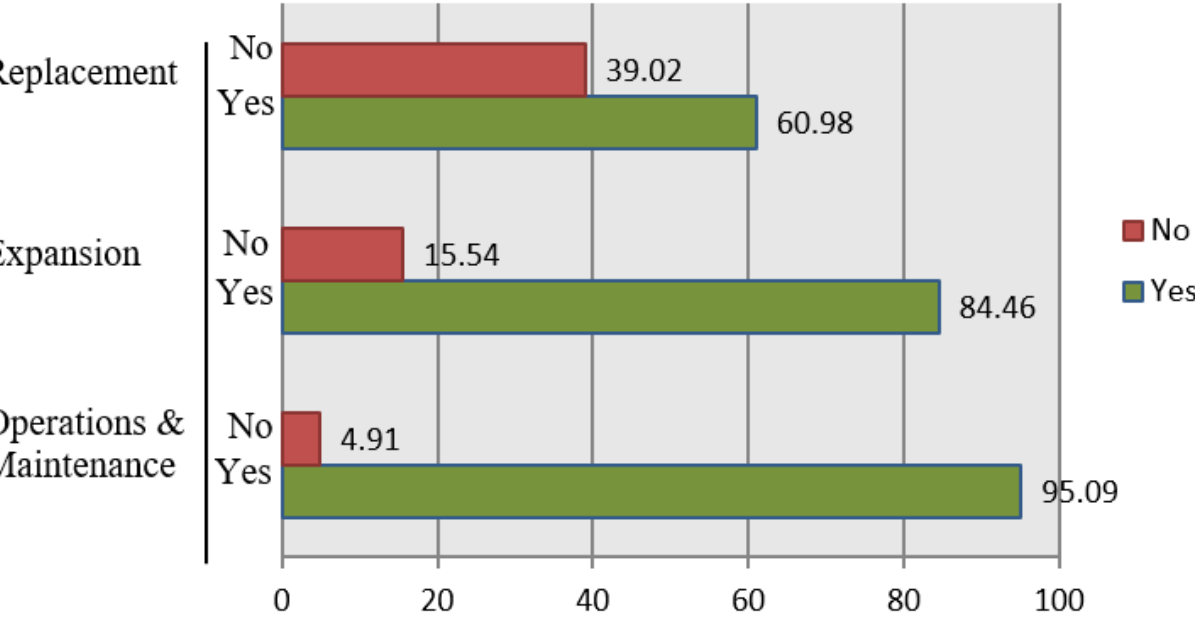
Figure 1. Perception of revenue for operations, expansion and system